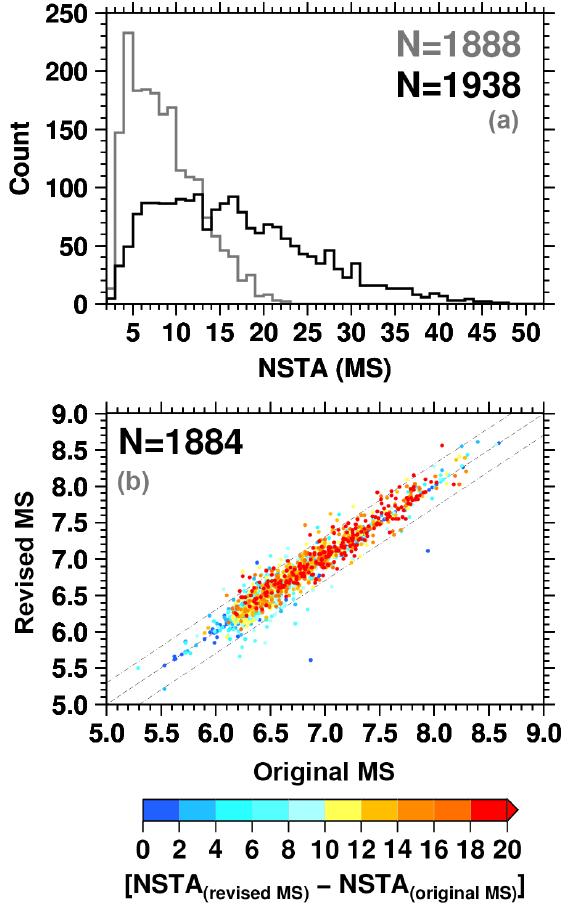
Figure 22. (a) Histogram distributions of the number of stations (NSTA) contributing to M S for the pre-1960 earthquakes already in previous versions of the ISC-GEM Catalogue (grey) and after revi- sion (black) using the newly added amplitude data. (b) Comparison between original and revised M S colour-coded by the difference of NSTA used to obtain M S . The black dashed and the dotted-dashed lines are for the 1 : 1 and the ± 0 . 3 values, respectively. Note that during revision we dropped the M S for four earthquakes.